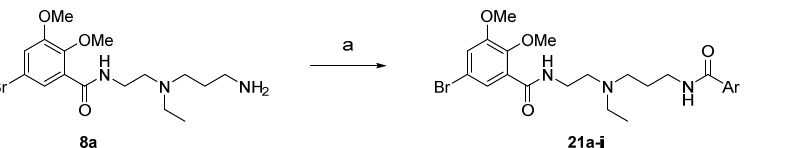
Table 1. Binding affinities and potency of R 1 and R 2 modified analogs with different length of the alkyl linker a